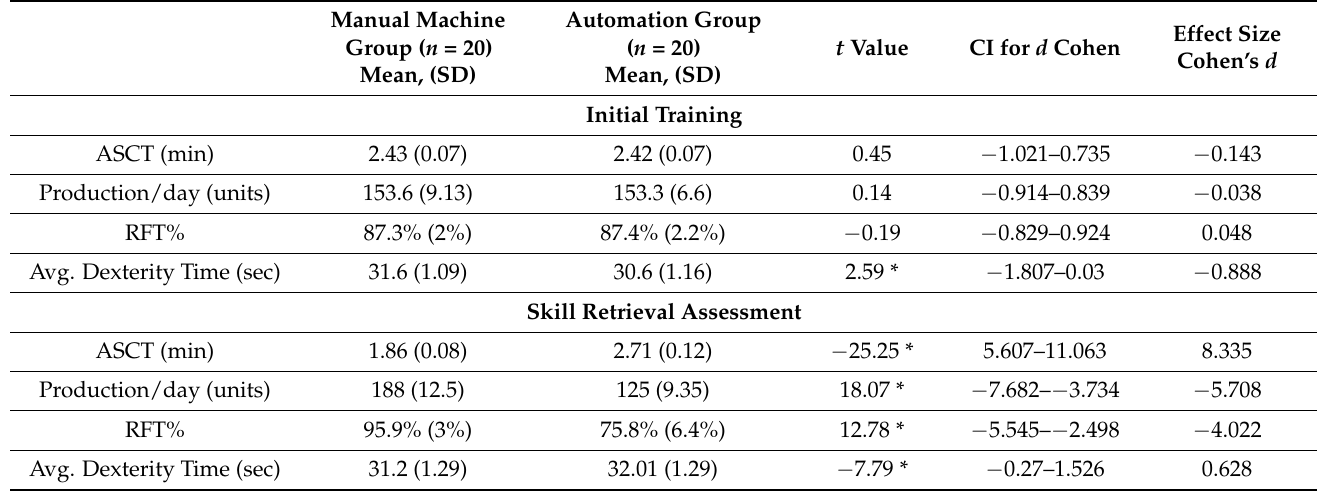
Table 2. Skill retrieval assessment among the MMG and AG using independent samples t -test.